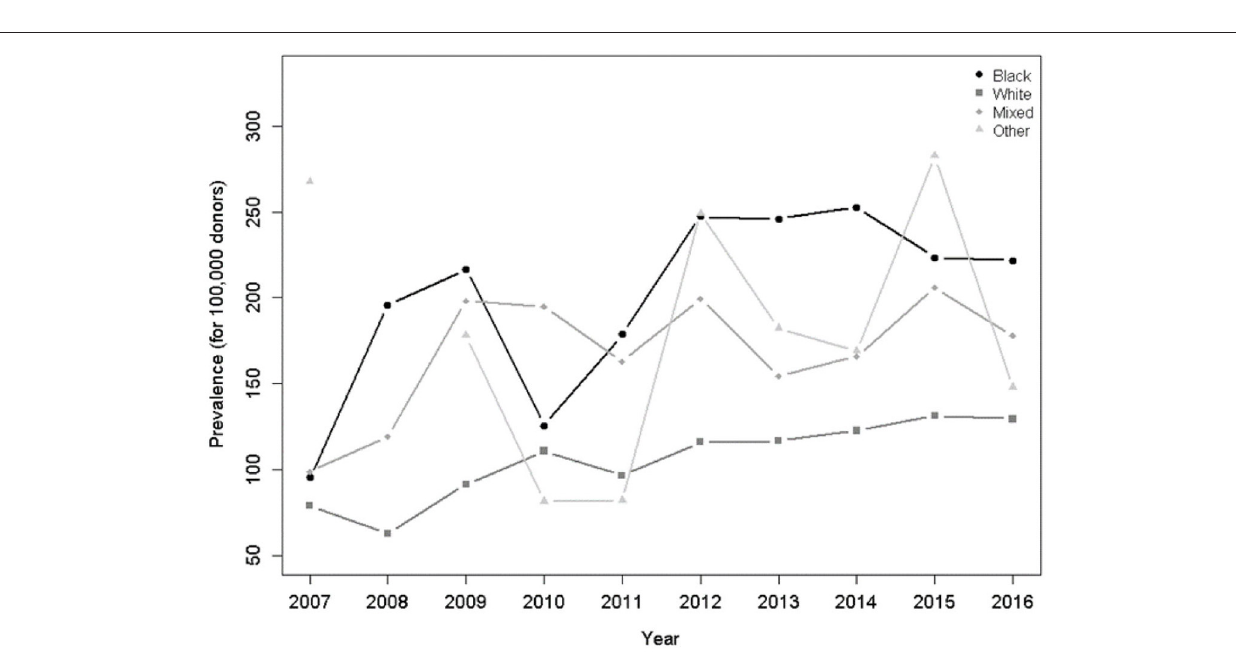
Rio de Janeiro, 660 in Belo Horizonte, and 320 in São Paulo (4). Although the comparison of the prevalence presented in these two studies has been hampered by divergent methods of testing, there was a reduction in rates in all capitals, as expected (1, 4).